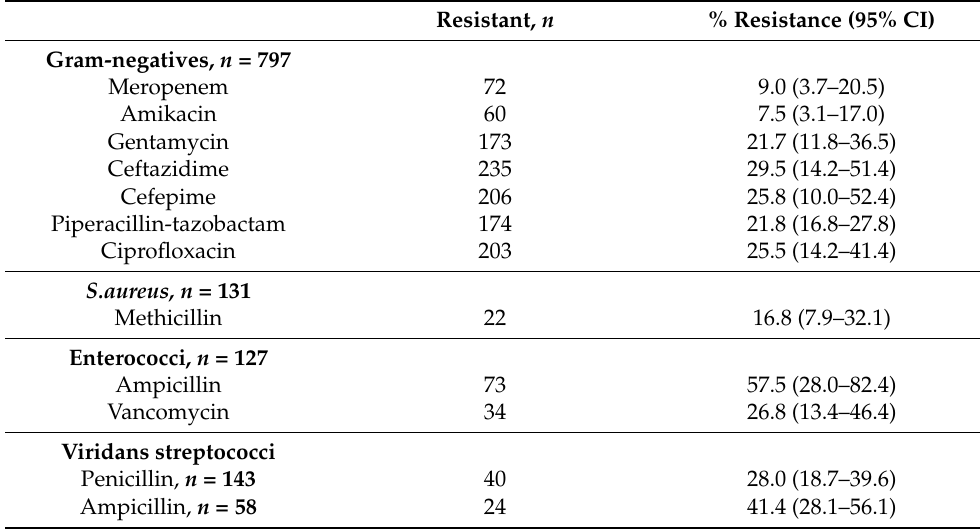
Table 1. Proportions of strains resistant to the antibiotics most frequently used against Gram- negatives and for specific